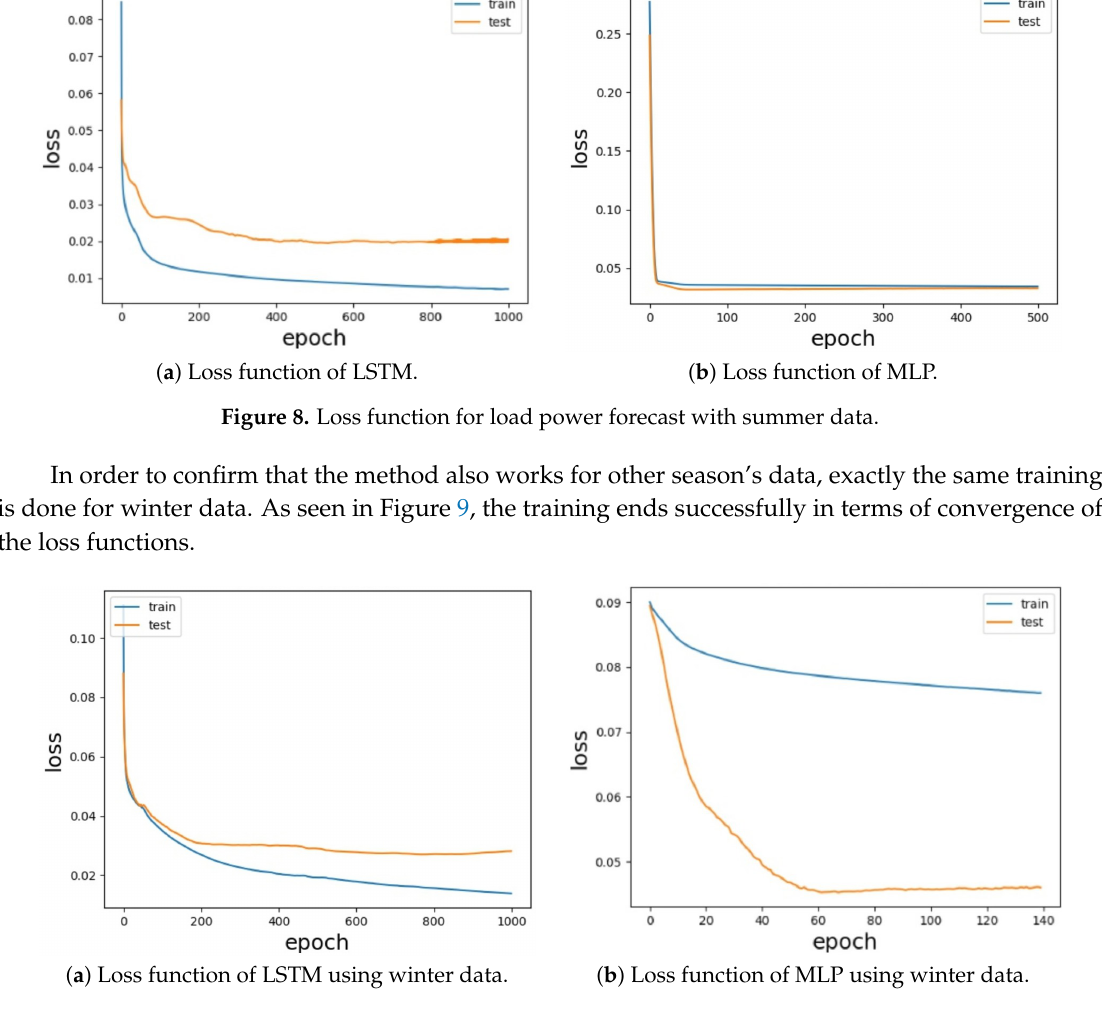
Figure 9. Loss function for load power forecast with winter